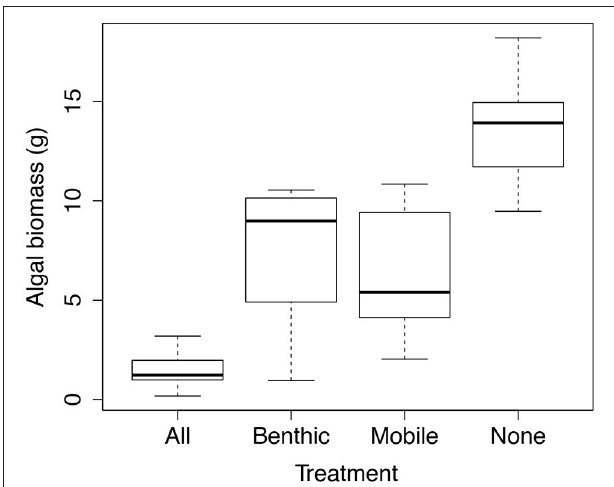
FIGURE 6 | Herbivore effects on algal biomass, plotted as final wet mass at the conclusion of the 10 week field experiment. Treatment labels indicate which herbivores were able to access the plots. “Benthic” = urchins (and potentially other benthic grazers) and “Mobile” = fishes, iguanas, and turtles. n = 10.